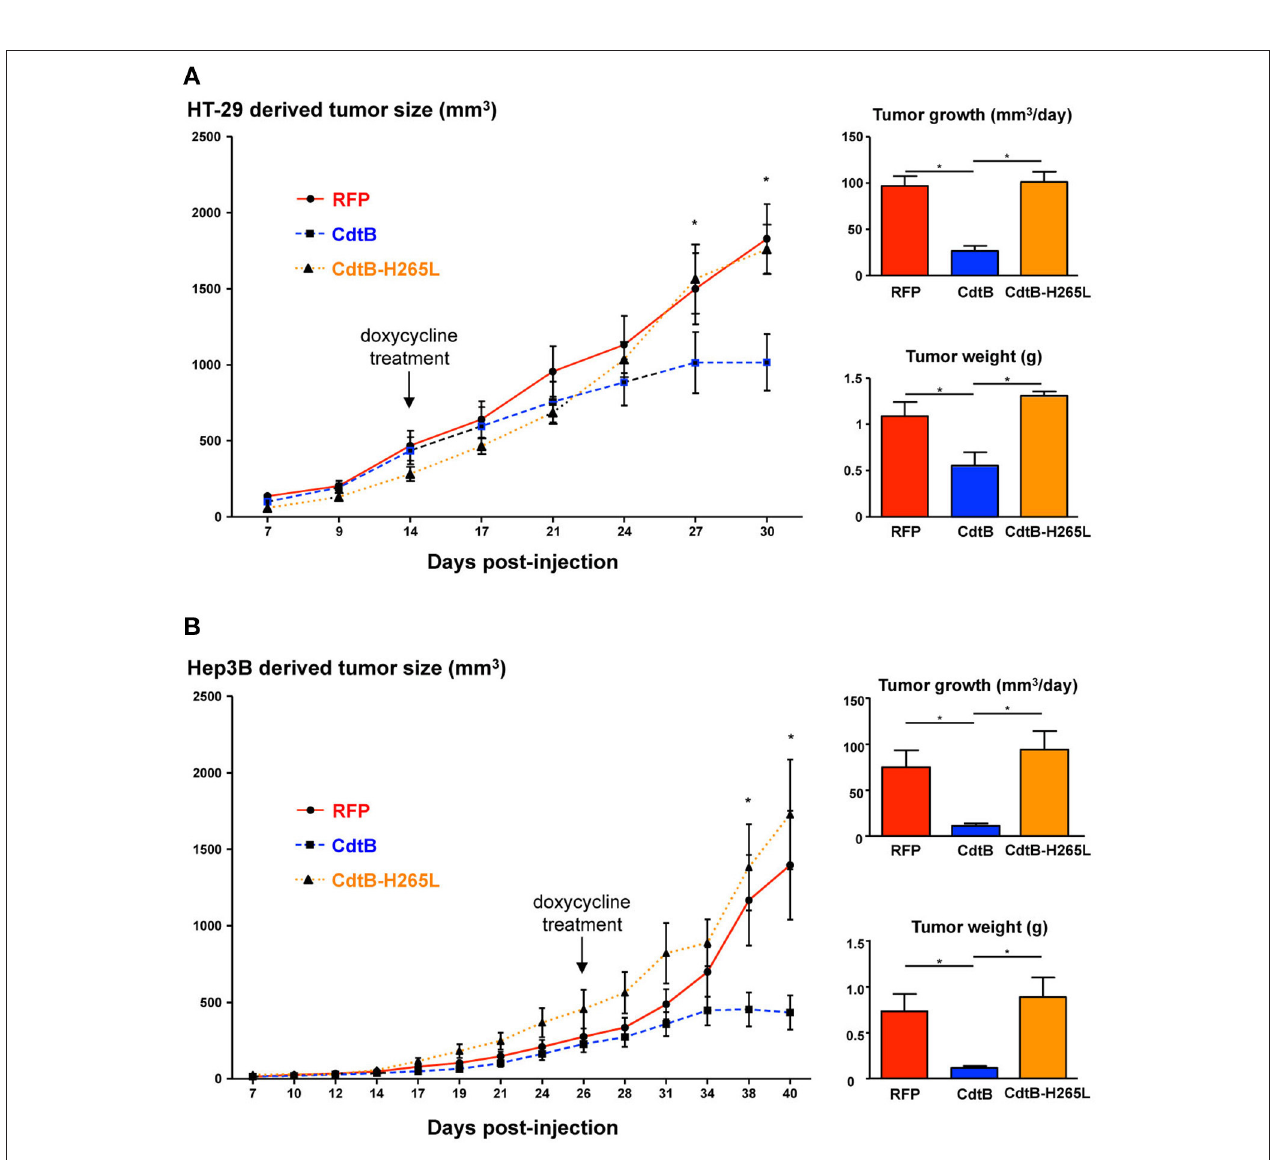
FIGURE 2 | Effects of the CdtB subunit of Helicobacter hepaticus CDT on tumor growth. HT-29 (2 × 10 6 cells) and Hep3B (4 × 10 6 cells) were injected subcutaneously into the flank of immunodeficient NSG and tumor size was monitored 3 times per week. When the engrafted HT-29- and Hep3B-derived tumors reached approximately 400 and 200 mm 3 , respectively, doxycycline was administered per os permanently to all of the mice. (A) HT-29- and (B) Hep3B-derived tumor growth in mice. The curves represent the tumor growth. The daily tumor growth was also calculated from the beginning of the doxycycline treatment until the sacrifice of mice. The tumor weight was also measured at necropsy. The arrows indicate the first day of administration of doxycycline. CdtB, CdtB of H. hepaticus strain 3B1. CdtB-H265L, H. hepaticus CdtB with H265L mutation; RFP, red fluorescent protein. * p < 0.05.